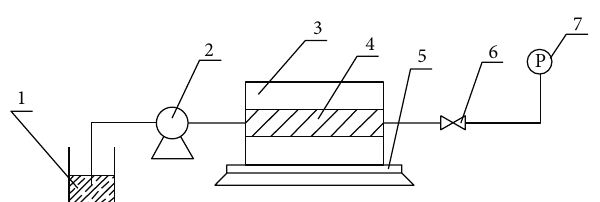
Figure 1: Flow chart of the water absorption experiment: 1: liquid reservoir; 2: plunger pump; 3: core holder; 4: mudstone core; 5: electronic scale; 6: back-pressure valve; 7: pressure